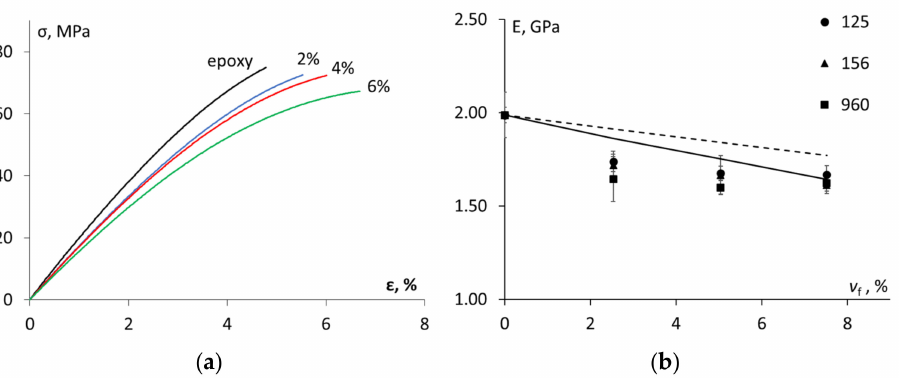
Figure 3. Stress–strain curves for the epoxy and epoxy filled with ACE MX-156 at different filler fractions indicated on the graph ( a ) and elastic modulus vs. filler volume fraction (dots -experimental results for different CSR nanoparticles, dashed and solid lines—evaluation by Equation (14) and by Equation (12), respectively ( b